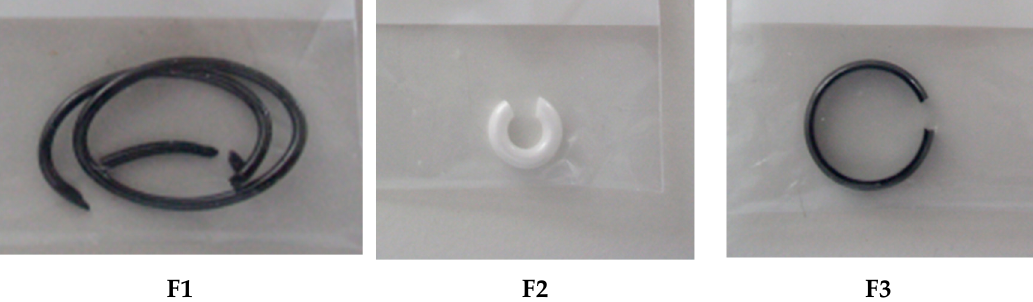
Figure 22. Zirconia ceramic rings: samples F1, F2 and F3. Table 13. Test samples. Mass and dissolution time.